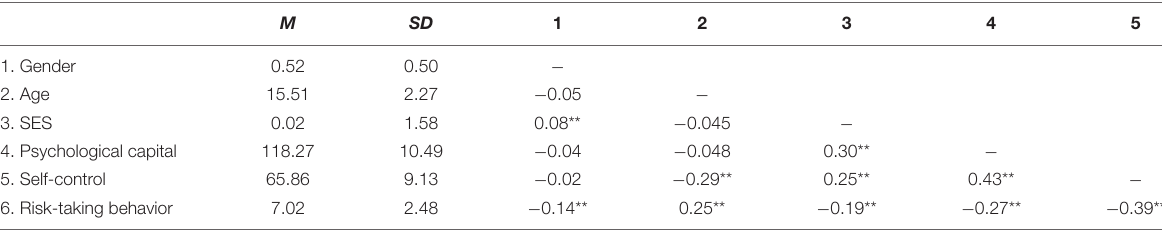
TABLE 1 | Descriptive statistics and correlations between variables.